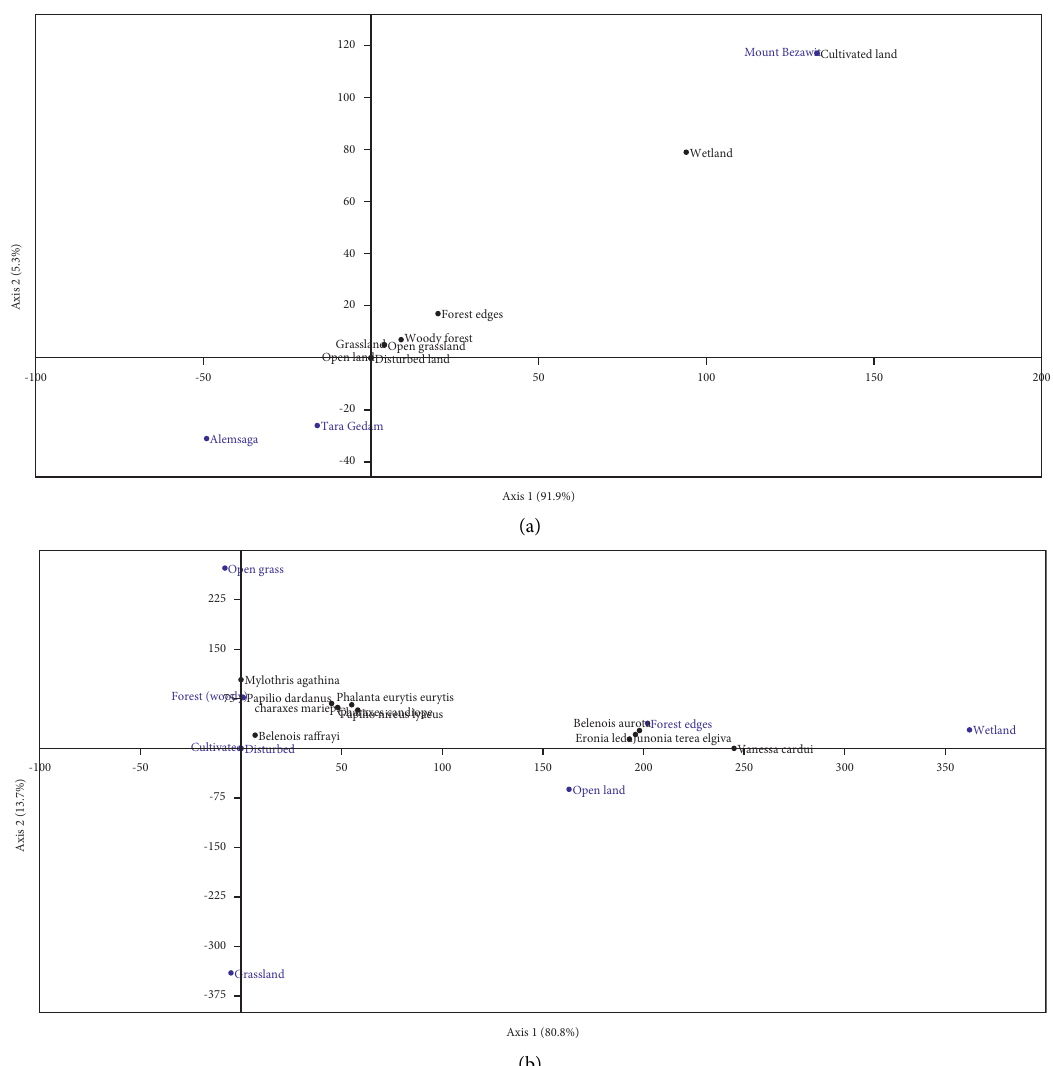
Figure 6: Ordination of study location and habitats (a) and habitats and butterfly species (b) by detrended correspondence analysis in Tana Basin (northwestern